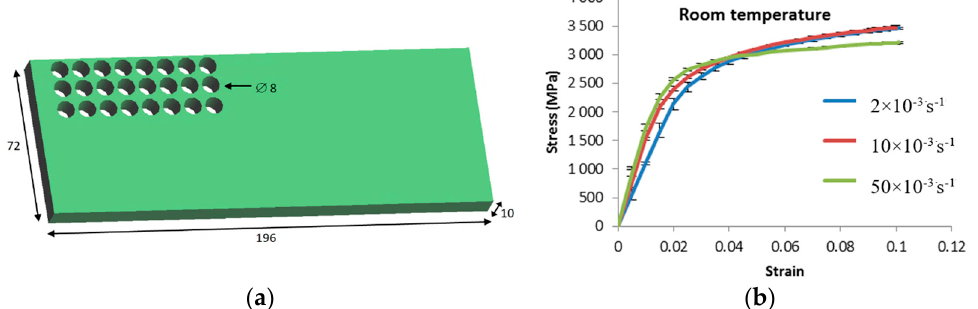
Figure 11. ( a ) Compression samples of ø 8 mm cut from a powder-based laser metal deposition (LMD-P) sample of 196 × 72 × 10 mm. ( b ) True stress–strain curves for different strain rates at room temperature.